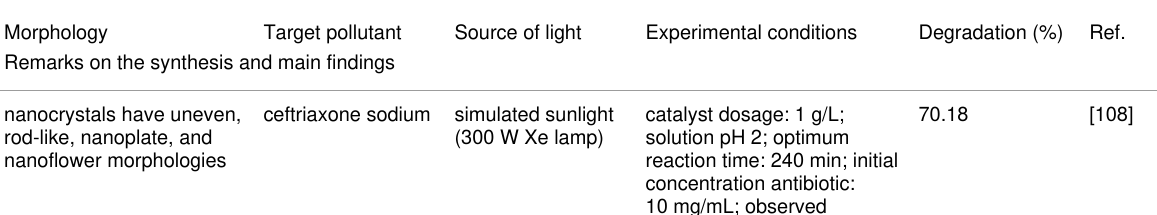
Table 3: Bi 2 WO 6 -based nanostructured materials for remediation of antibiotics and dyes.